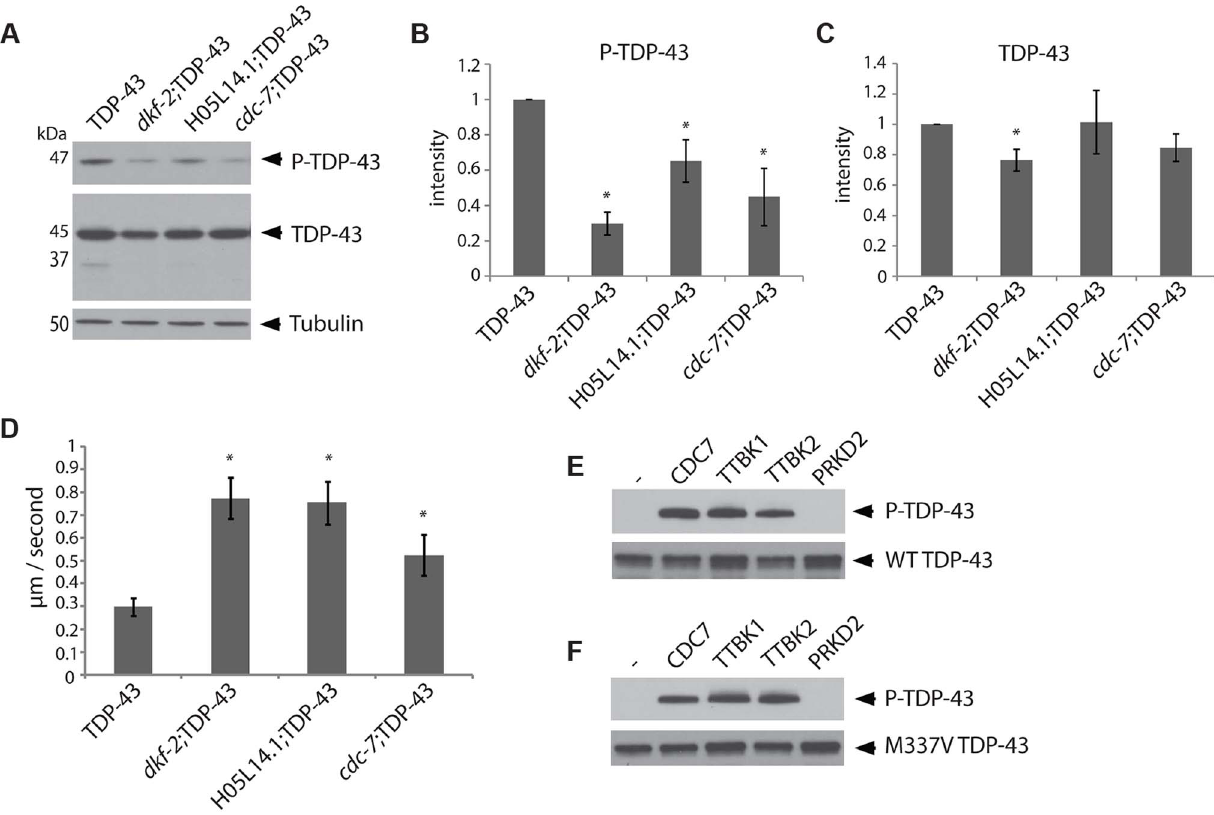
Figure1.ThekinasesTTBK1/2phosphorylateTDP-43in C.elegans and invitro . (A)Developmentallysynchronizedday1adult dkf-2( 2 / 2 ) ;TDP- 43, cdc-7( 2 / 2 ) ;TDP-43, and H05L14.1( 2 / 2 );TDP-43 kinase mutants have decreased phosphorylated TDP-43 relative to TDP-43 transgenic animals alone. See S2 Figure for overexposure of immunoblots. Measurement of protein levels of three independent immunoblots is presented for phospho- TDP-43 (B) and total TDP-43 (C). Signal is normalized to the parental TDP-43 transgenic control strain, and graphs are plotted in arbitrary units of intensity. * P , 0.05, Student’s t-test relative to TDP-43 transgenic control. (D) Developmentally staged kinase mutant/TDP-43 transgenic L4 larvae exhibit significantly higher dispersal velocity relative to TDP-43 transgenic animals with intact kinase genes. Animals were measured for the linear distance traveled from a central reference point over time, N . 70 for each genotype. * P , 0.05 versus TDP-43. Non-transgenic animals disperse at an average velocity of 5.9 m m/second. (E) In vitro kinase assays testing the kinase activity of TTBK1, TTBK2, and PRKD2 against wild-type TDP-43 demonstrate purified TTBK1 and TTBK2 phosphorylate wild-type TDP-43, while PRKD2 does not. Immunoblots are probed with antibodies for phosphorylated (P-TDP-43) and total TDP-43. (F) In vitro kinase assays demonstrate purified TTBK1 and TTBK2 but not PRKD2 phosphorylate M337V mutant TDP-43. See S4 Figure for controls of kinase activity on known protein substrates.